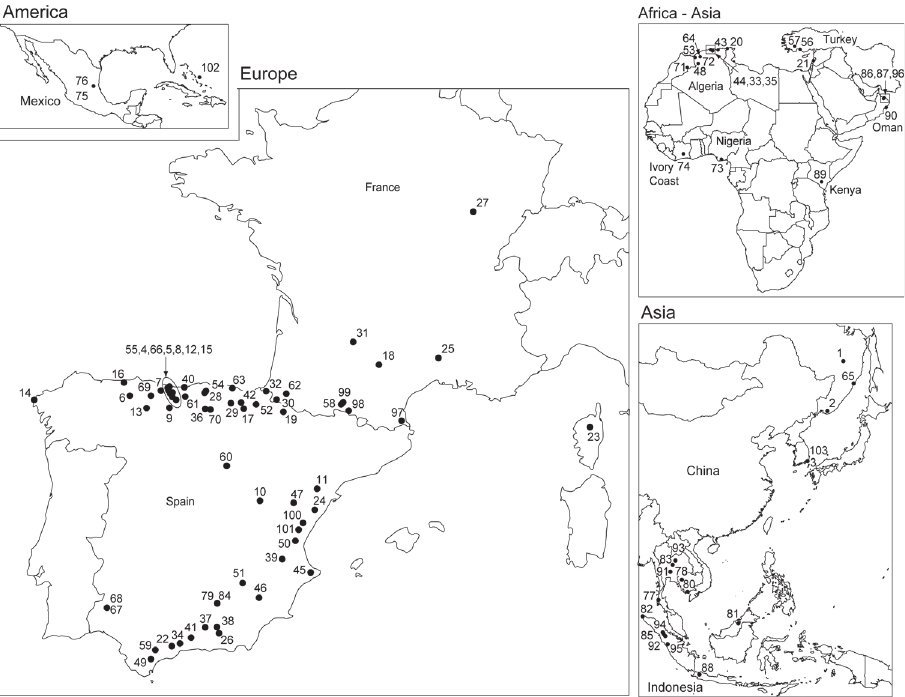
Figure 1. Maps showing the location of the 103 species and subspecies of aquatic isopods described or co-described by Guy Magniez. Numbers indicate taxa, the names of which are provided in Table